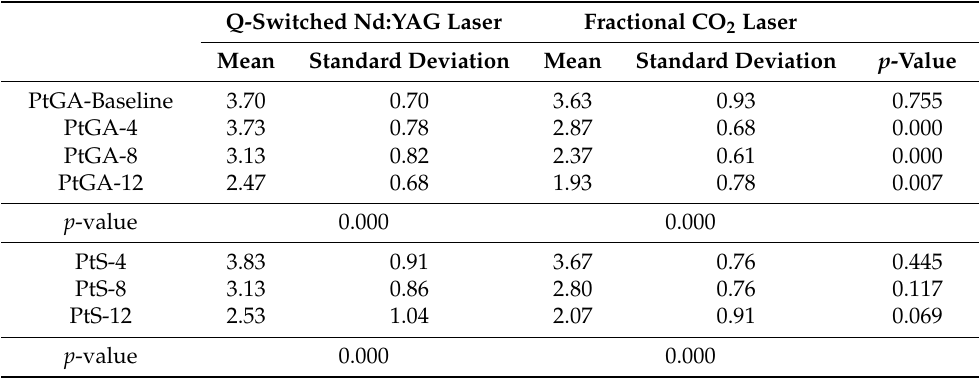
Table 1. Mean and standard deviation of PtGA and PtS over time.